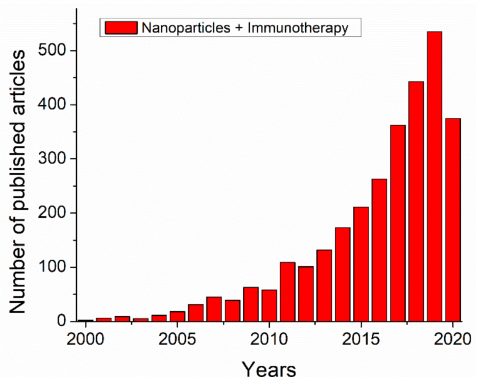
Figure 1. A number of published papers for the last two decades (i.e., 2000–2020) by searching on PubMed using key words “nanoparticles +